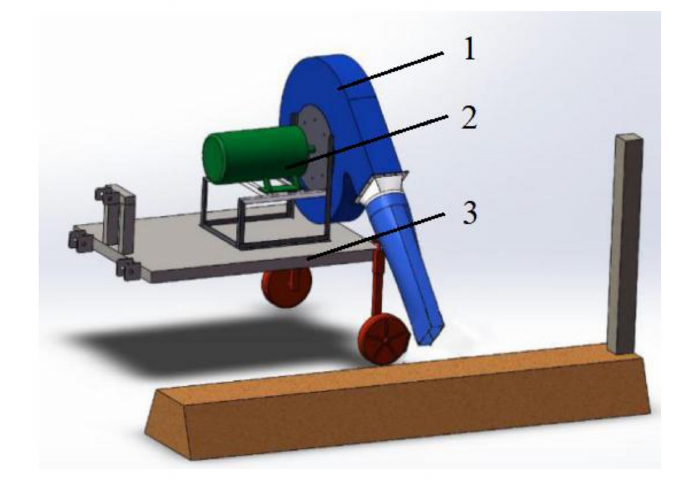
Figure 2. Overall structure. 1: fan, 2: power device, 3: